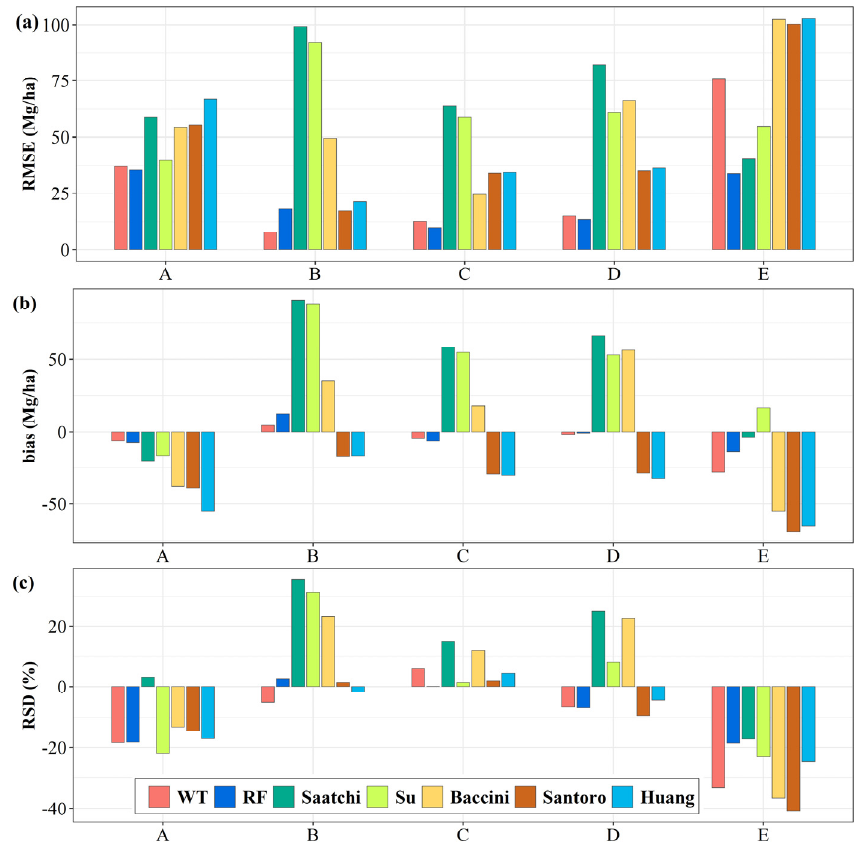
Figure 3. ( a ) RMSE, ( b ) bias, and ( c ) RSD of the hybrid and participating products computed using the out-of-sample test.